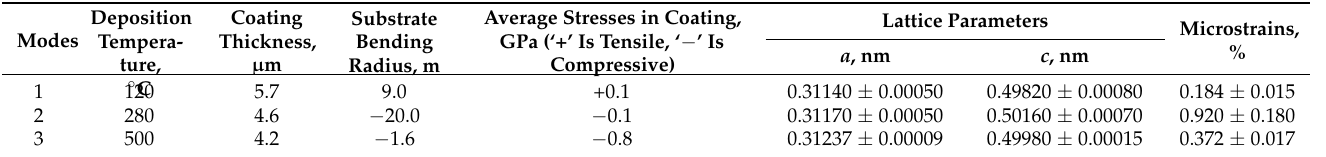
Table 1. The deposition conditions and properties of the trial AlN coatings.